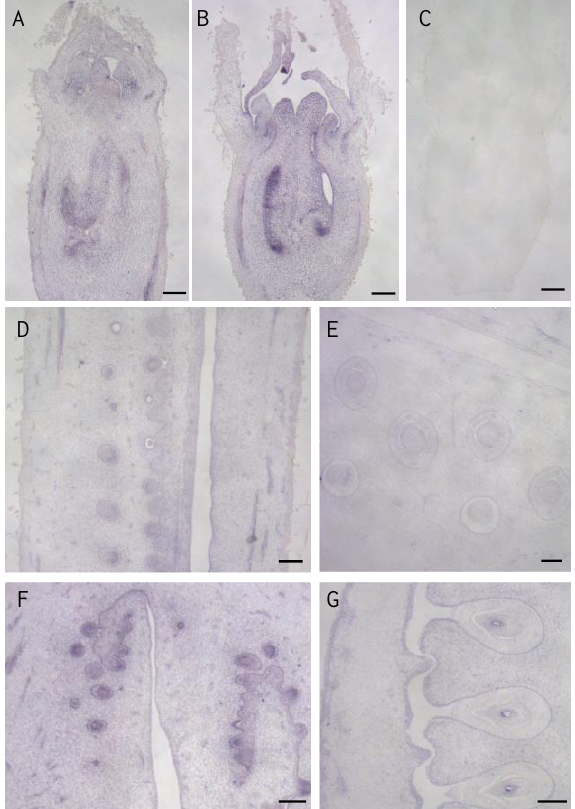
Figure 5. In situ hybridization of LsOVATE1 . ( A , B ) show longitudinal sections of young ovaries at 8 days before anthesis in HZ and YD-4, respectively; ( D , E ) show longitudinal sections of young ovaries at 4 days before anthesis in HZ and YD-4, respectively. ( F , G ) show longitudinal sections of ovaries on the day of anthesis in HZ and YD-4, respectively. ( C ) indicates that negative controls successfully hybridized with the sense probe. Scale bar = 200 µM.